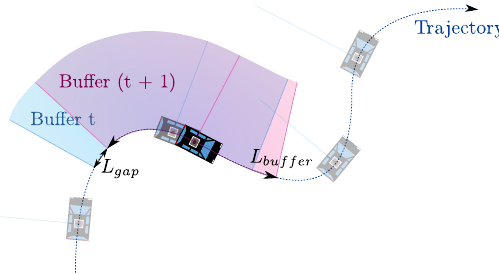
Figure 8: Sketch of two point buffers, according to a virtual posi- tion of the vehicle t and the next one (t + 1) shifted with L gap .